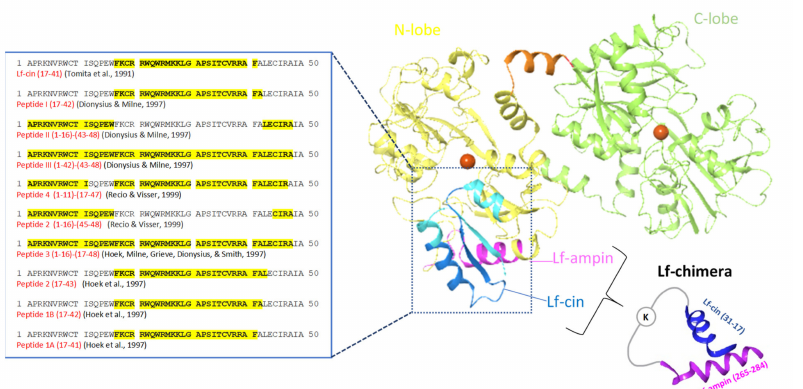
Figure 4. Structure of the bovine lactoferrins. Blue ribbon, antibacterial domain of bovine lactoferrin, from where the lactoferrin-derived peptides with antibacterial activities were obtained, with their amino-acid sequences given on the left. Darker blue ribbon, bovine lactoferricin (Lf-cin); violet ribbon, lactoferrampin (Lf-ampin; amino acids 268–284). Chimerization of lactoferricin 17–30 and lactoferrampin 265–284 produced lactoferrin (Lf)-chimera, where these two peptides were coupled through the two amino groups of a lysine (adapted from